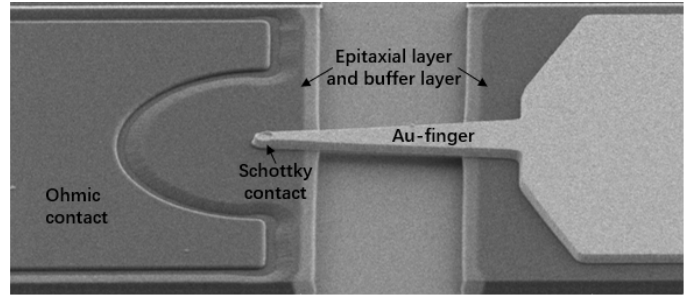
Figure 2. Scanning electron micrograph of a lithographically defined Schottky diode.